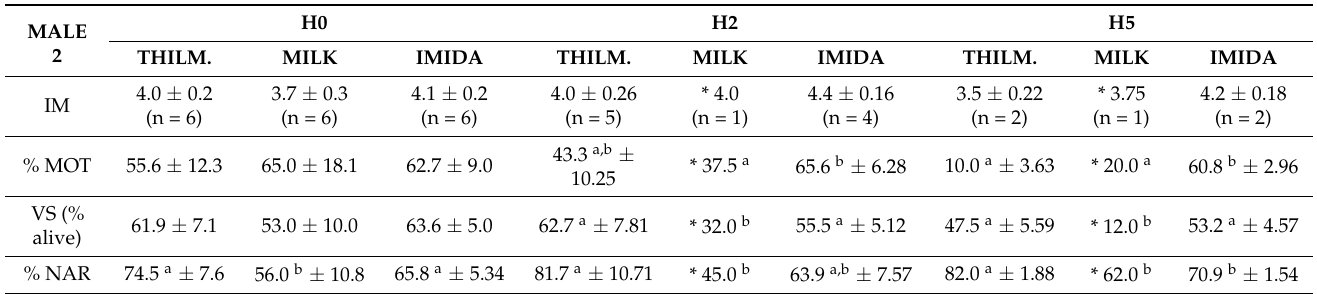
Table 11. Average semen quality parameters by subjective microscopic evaluation for male 2 in endurance test, according to extender.